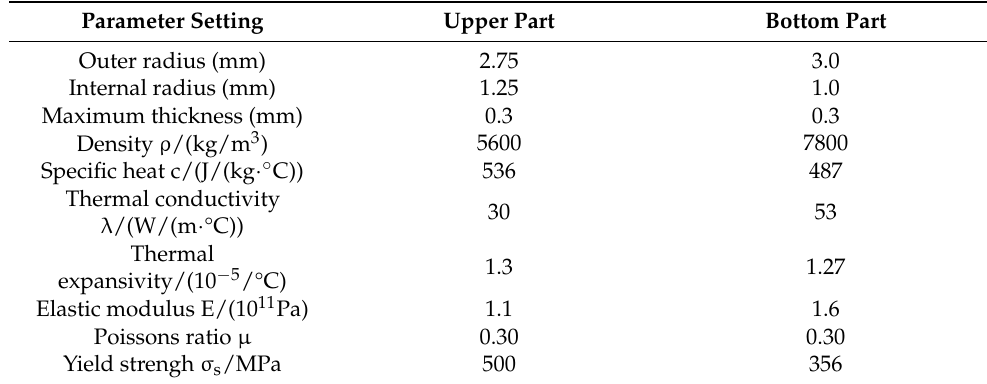
Table 1. Structure and material property parameters of finite element friction